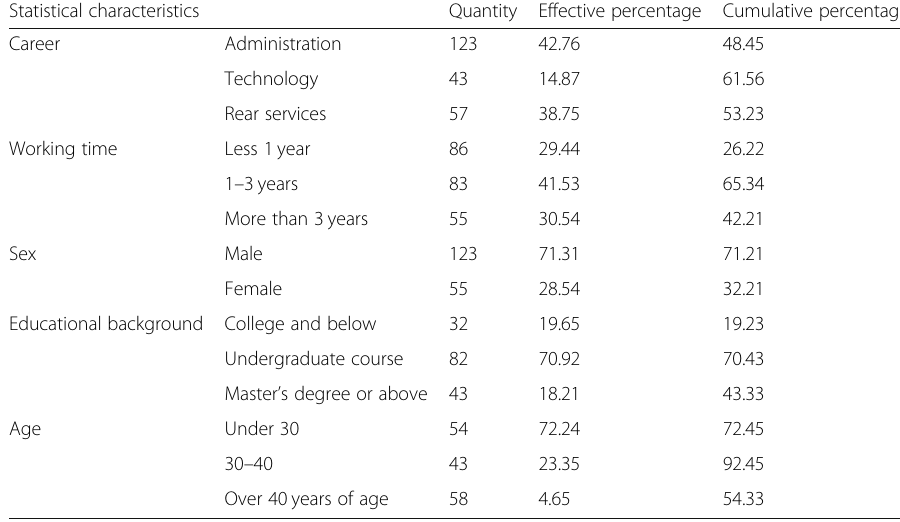
Table 4 Basic information of government administrators Statistical